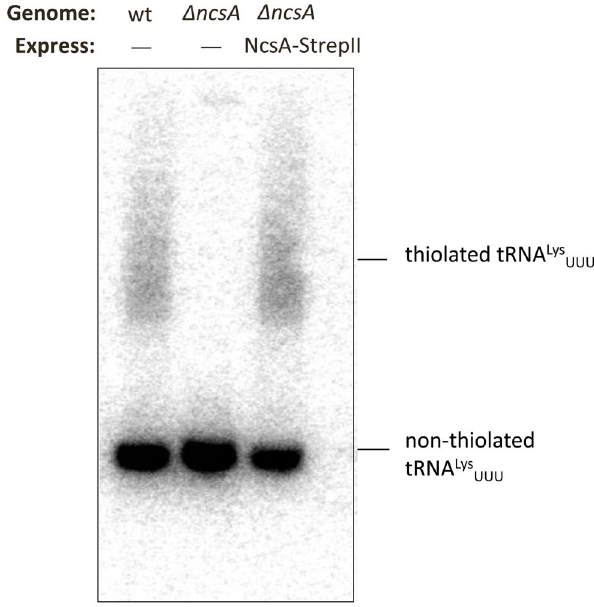
Figure 2. Hfx. volcanii NcsA is required for thiolation of tRNA Lys UUU . Total RNA was isolated from H26 (wt, parent), D ncsA ( D hvo_0580 ), and trans complemented D ncsA strains, electrophoresed in a 12% urea polyacrylamide gel supplemented with 30 m g APM per ml, and hybridized to a probe complementary to tRNA Lys UUU by Northern blotting. For further details see Methods section. Thiolated tRNA Lys UUU migrates slower than non-thiolated tRNA Lys UUU as indicated.